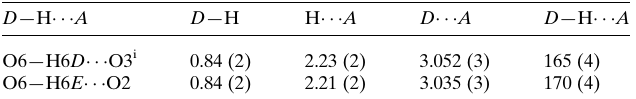
Table 2 Hydrogen-bond geometry (A˚ , (cid:5) ) for II .